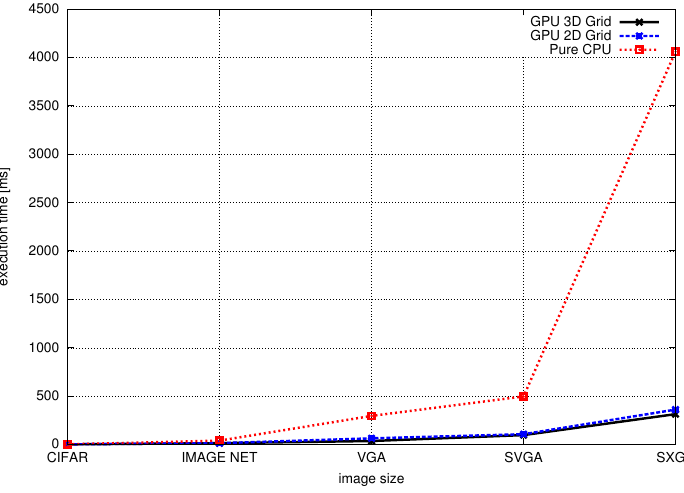
Figure 9. Rectifier linear unit performance on the mobile device as a function of the input image